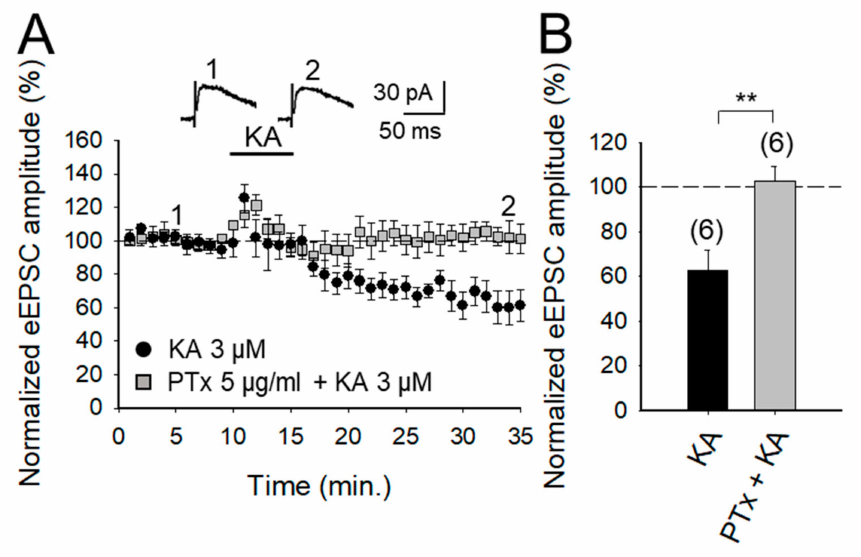
Figure 3. KAR-mediated depression of glutamate release is prevented in slices treated with pertussis toxin. ( A ) Time-course of the e ff ect of KA on eEPSC amplitude in control slices and in slices treated with pertussis toxin. Inset shows representative traces showing that KA (3 µ M) does not a ff ect the amplitude of the eEPSCs in pertussis toxin-treated slices. ( B ) Summary of results. The number of slices (from two to three mice) is indicated in parentheses at the top of each bar. Results are expressed as means ± SEM (** p < 0.01, Student’s t